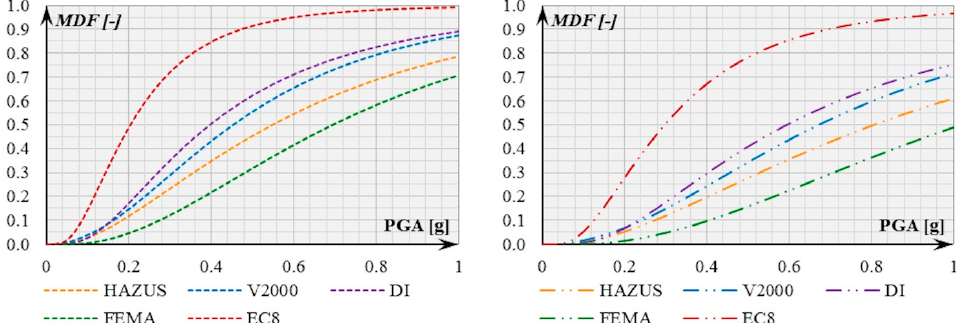
Figure 23. Vulnerability curves for each damage assessment method, for lower ( left ) and upper ( right ) CI bounds.